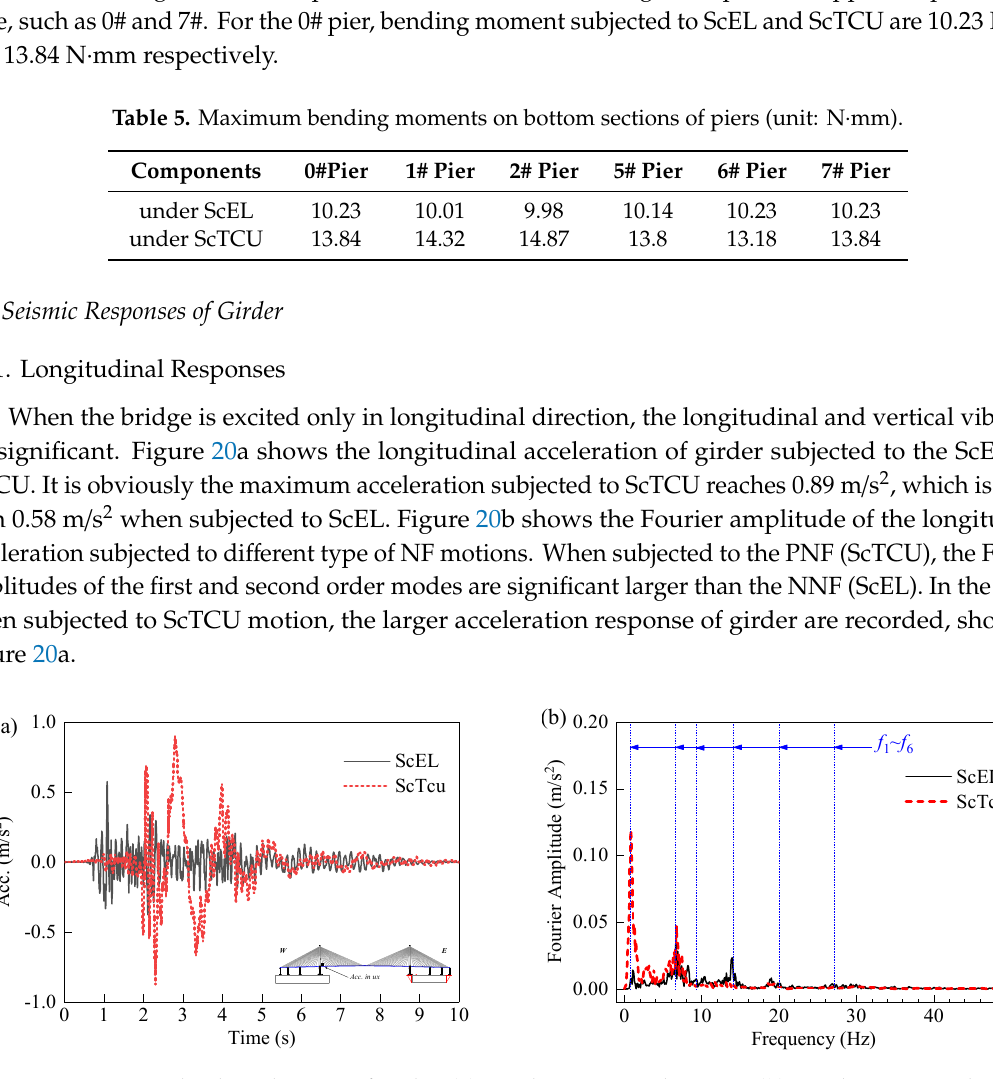
Table 5. Maximum bending moments on bottom sections of piers (unit: N·mm).